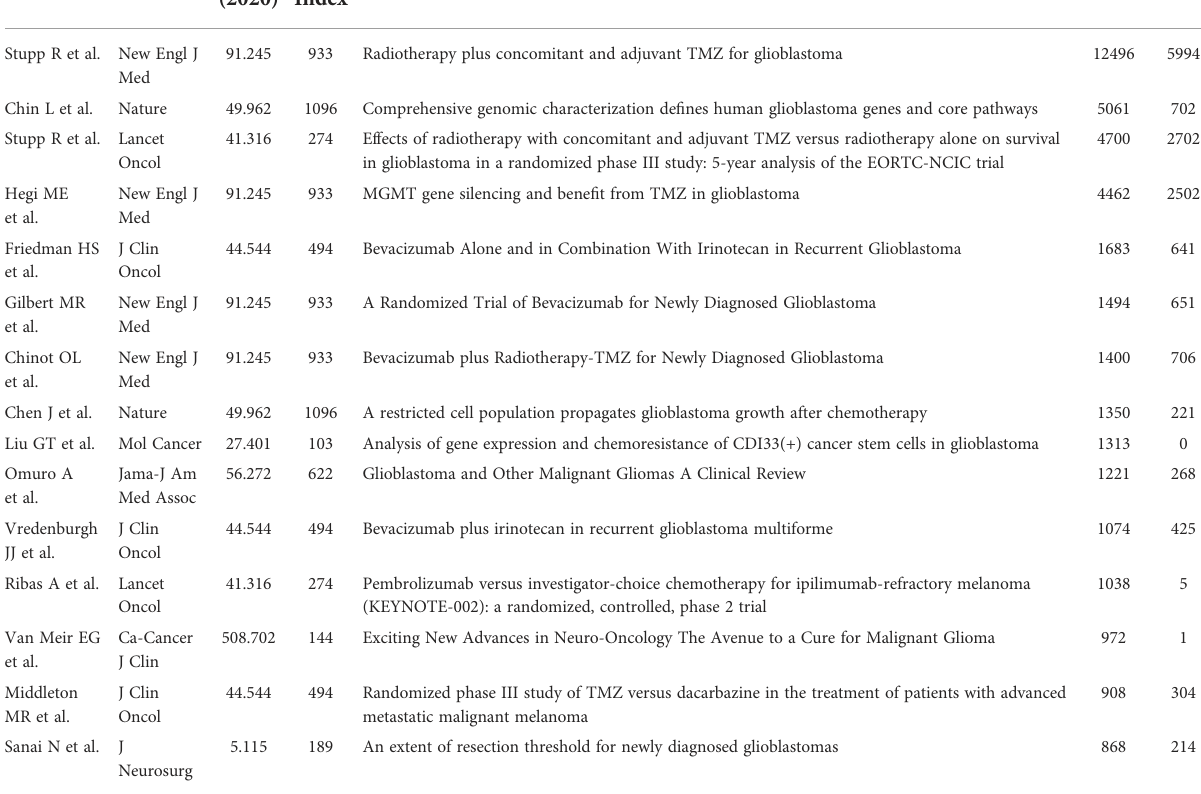
TABLE 5 The top 15 most cited